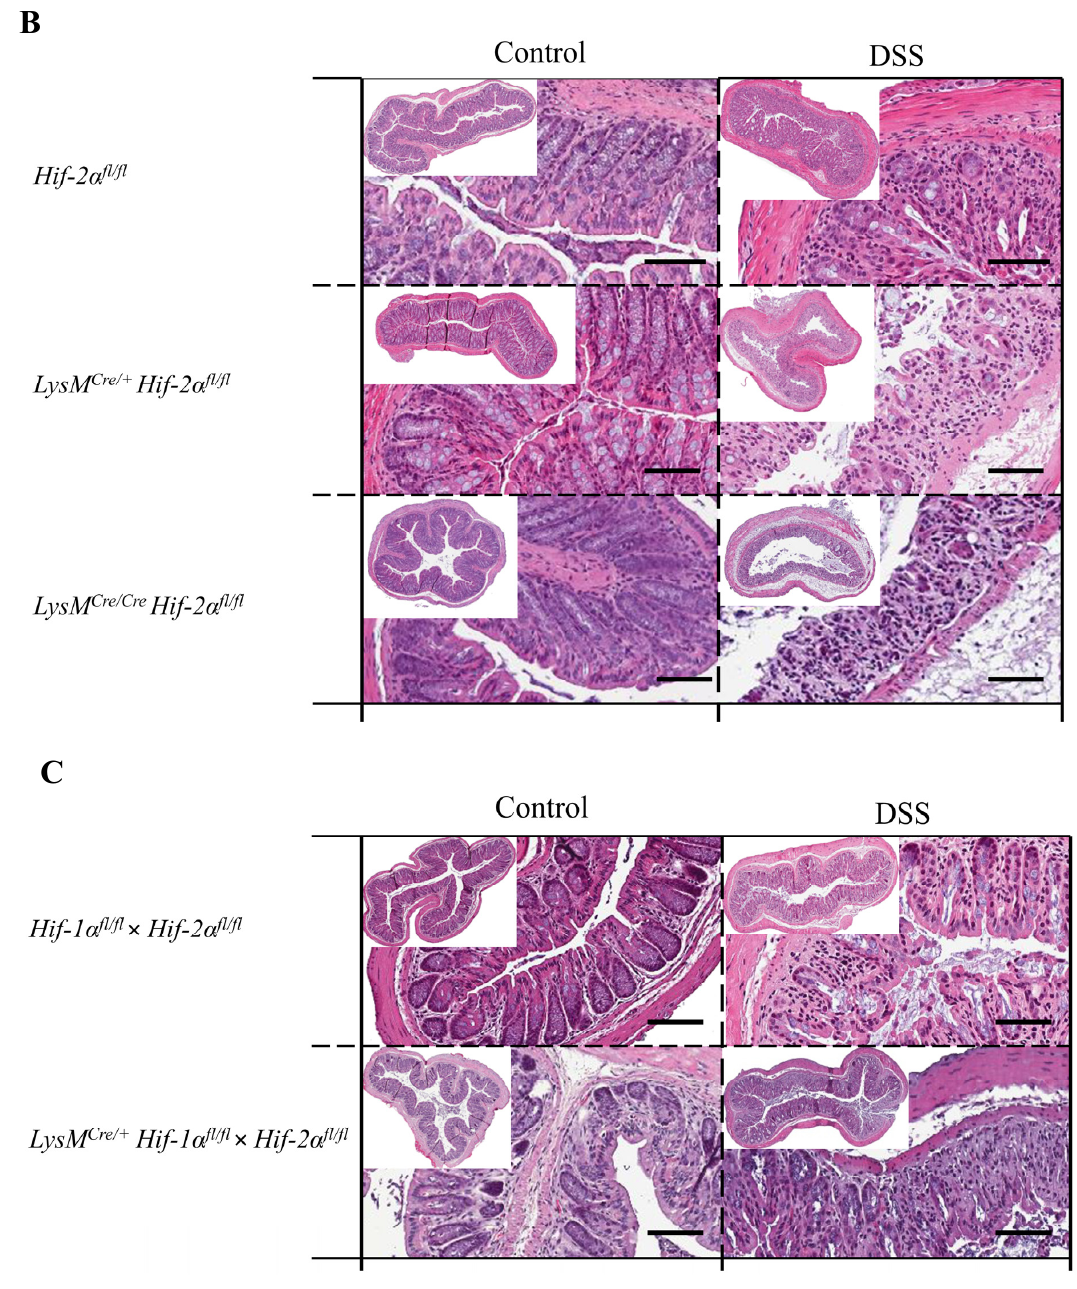
Figure 2. Myeloid knockout of HIF-1 α leads to low tissue destruction, while myeloid knockout of HIF-2 α increased it. Exemplary presentation of H&E-stained colon tissue sections of ( A ) Hif-1 α fl/fl , LysM Cre/+ Hif-1 α fl/fl animals, ( B ) Hif-2 α fl/fl , LysM Cre/ + Hif-2 α fl/fl and LysM Cre/ Cre Hif-2 α fl/fl animals, and ( C ) Hif-1 α fl/fl × Hif-2 α fl/fl and LysM Cre/+ Hif-1 α fl/fl × Hif-2 α fl/fl animals after DSS treatment and the control group. Tissue sections from DSS-treated LysM Cre/ Cre Hif-2 α fl/fl animals showed the highest structural damage of tissue. Tissue sections from DSS-treated LysM Cre/+ Hif-1 α fl/fl animals showed the least structural damage. A: n (Control) = 2, n (DSS) = 3; B: n (Control) = 3 ( LysM Cre/ Cre Hif-2 α fl/fl )/8 ( Hif-2 α fl/fl ; LysM Cre/ + Hif-2 α fl/fl ), n (DSS) = 8 ( LysM Cre/ Cre Hif-2 α fl/fl )/18 ( Hif-2 α fl/fl , LysM Cre/ + Hif-2 α fl/fl ); and C: n (Control) = 7, n (DSS) = 14. Magnification overview image: 100×; magnification detail image: 200×; and scale bar: 100 µm.